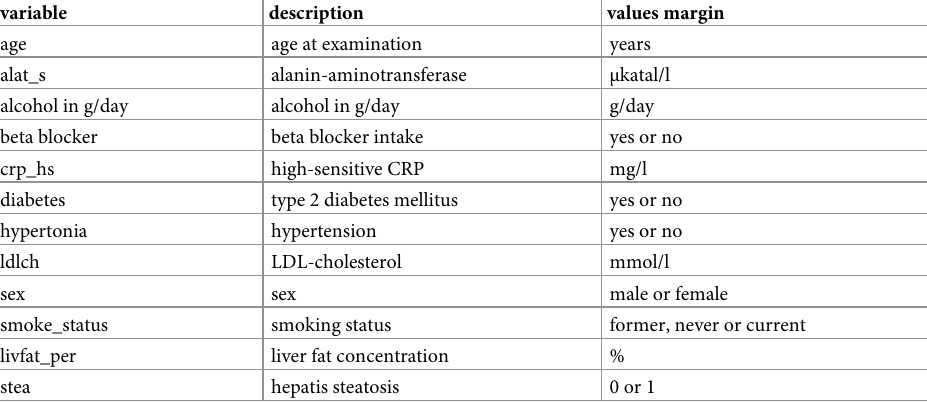
Table 1. Overview of used variables in the annotation